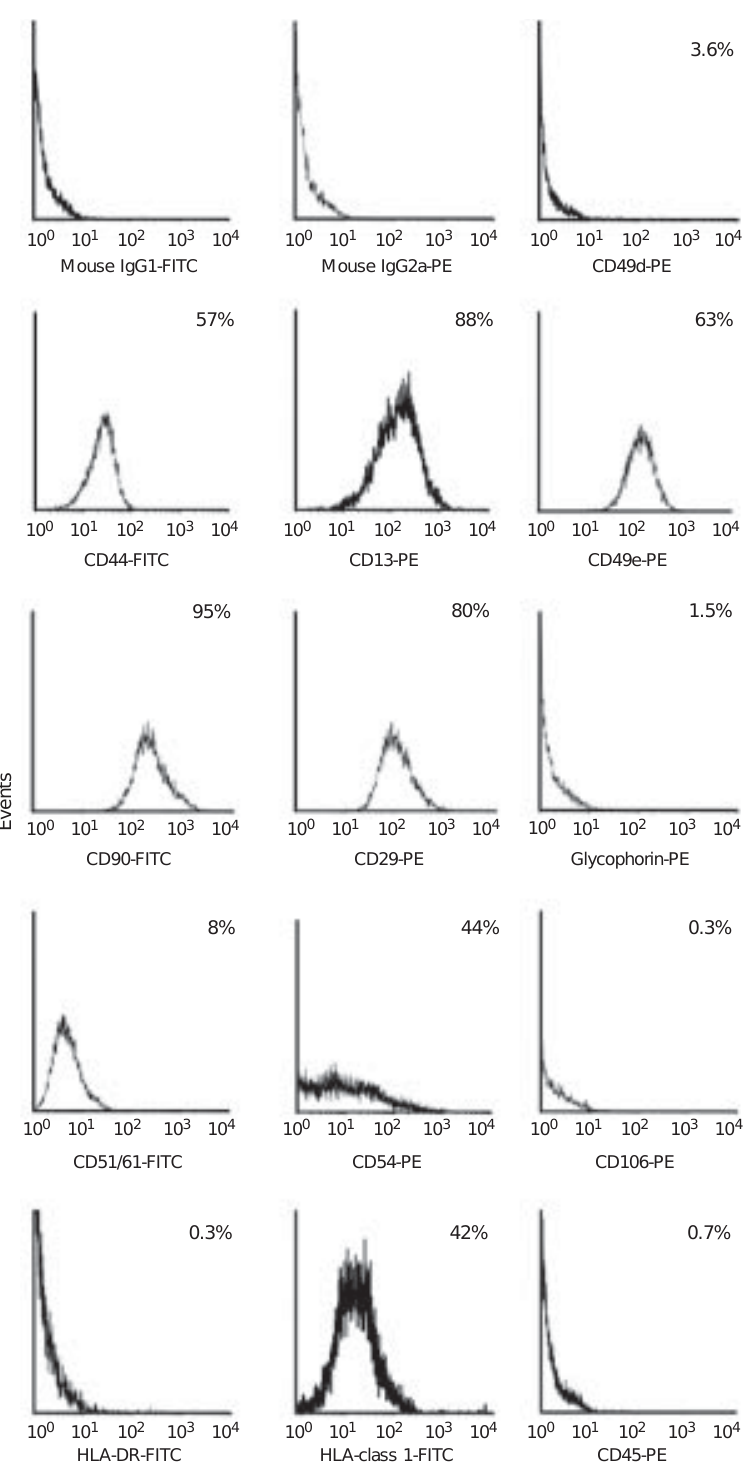
Figure 1. Flow cytometry histograms showing the immunophenotype of umbilical vein mesenchymal stem cells. The cells expressed CD13, CD90, CD29, CD44, CD49e, CD54 and HLA-class 1. The percent positivity of each marker is